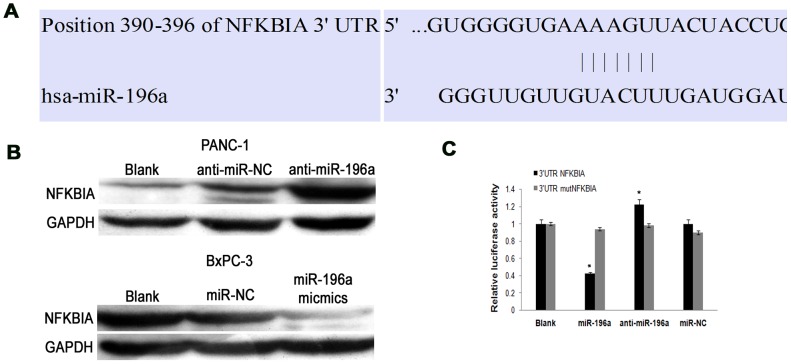
MiR-196a directly targets NFKBIA gene.(A) NFKBIA is a potential target gene of miR-196a predicted by computational analysis. (B) Representative western blot analysis showed the relationship between miR-196a expression and endogenous NFKBIA protein level. The inhibition of miR-196a in PANC-1 cells increased endogenous NFKBIA protein level, whereas overexpression of miR-196a in BxPC-3 cells attenuated endogenous NFKBIA protein level. (C) Insertion of NFKBIA3′UTR target sequences in a luciferase reporter vector leaded to diminished luciferase activity in presence of miR-196a in PANC-1 cells 24 h after co-transfection. Histograms showed the values resulting as the average ± SD from three independent co-transfections (*, P<0.05).